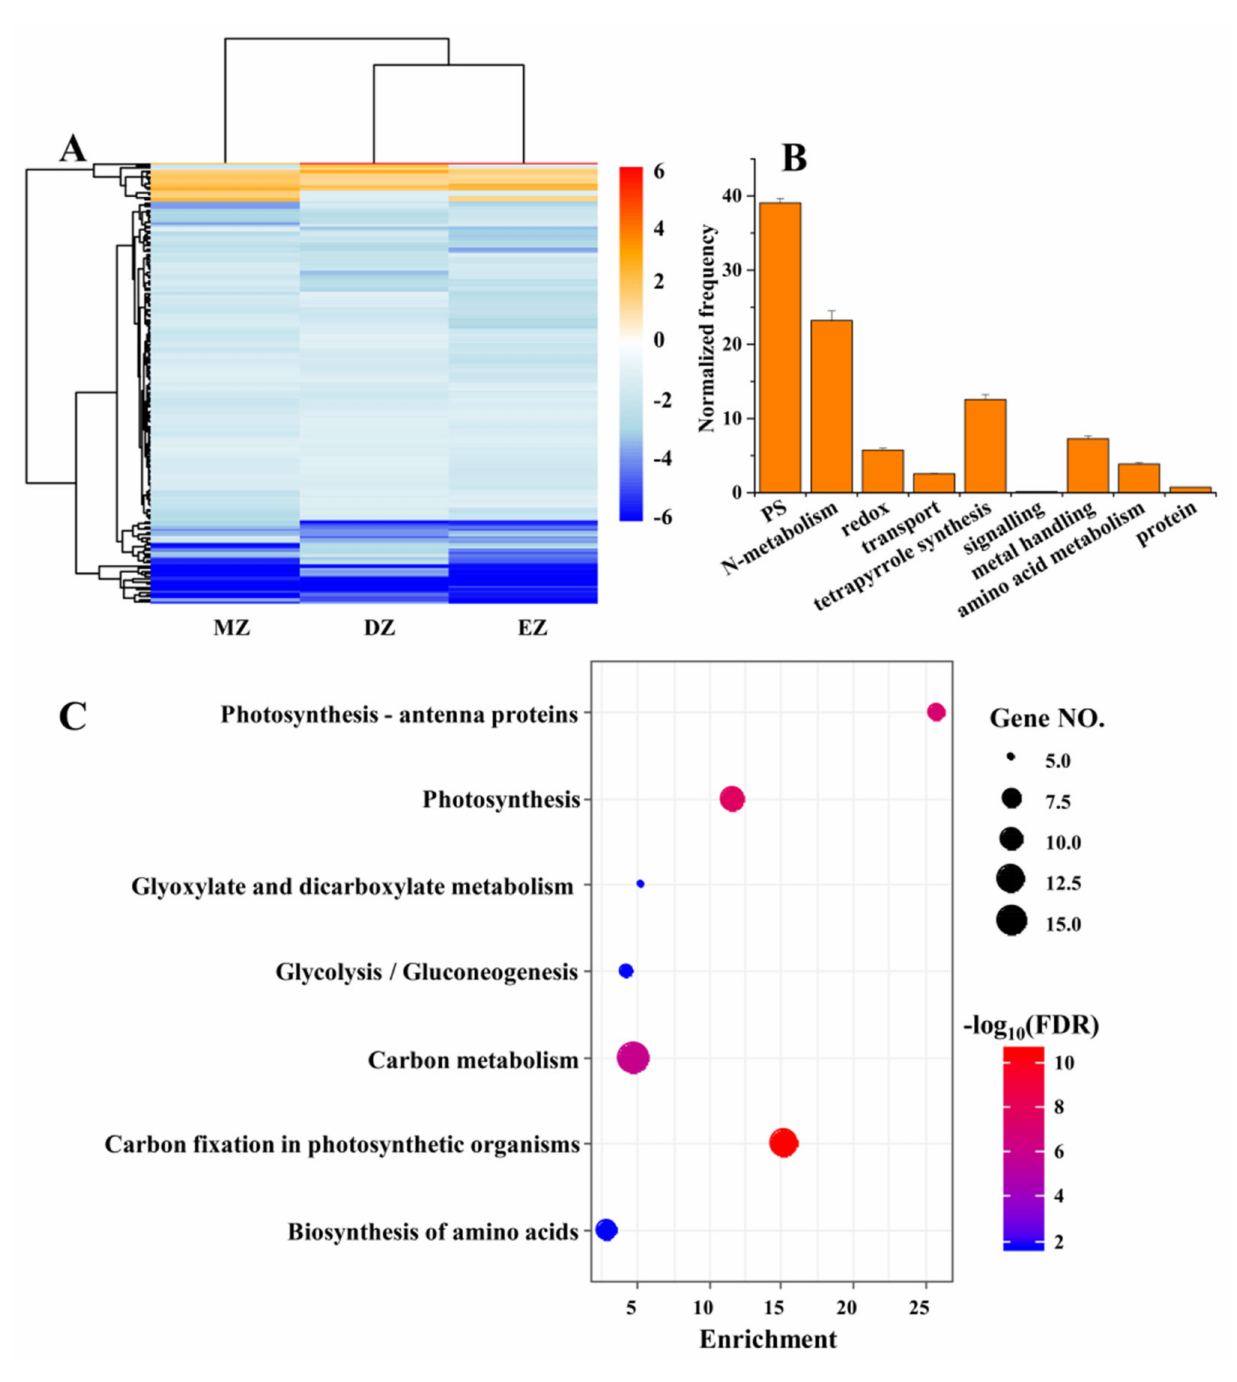
Figure 2. The heatmap represents the gene expression levels of common genes (CGs) under the comparisons of DZ, EZ, and MZ ( A ). The MapMan analysis ( B ) and KEGG ( C ) of CGs that are shared by the three comparisons. The MapMan analysis was conducted in BAR database (http: //bar.utoronto.ca/welcome.htm, accessed on 10 January 2020) with the Classification SuperViewer tool; only the significant terms are shown in the